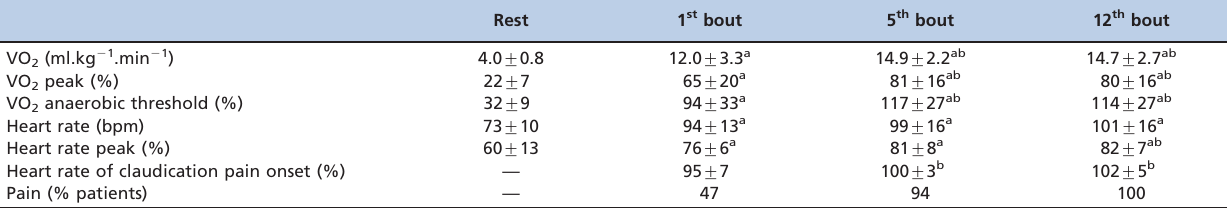
Table 2 - Cardiopulmonary responses and prevalence of claudication symptoms evaluated during a walking training session performed with the intensity prescribed at the heart rate of claudication pain onset (n=